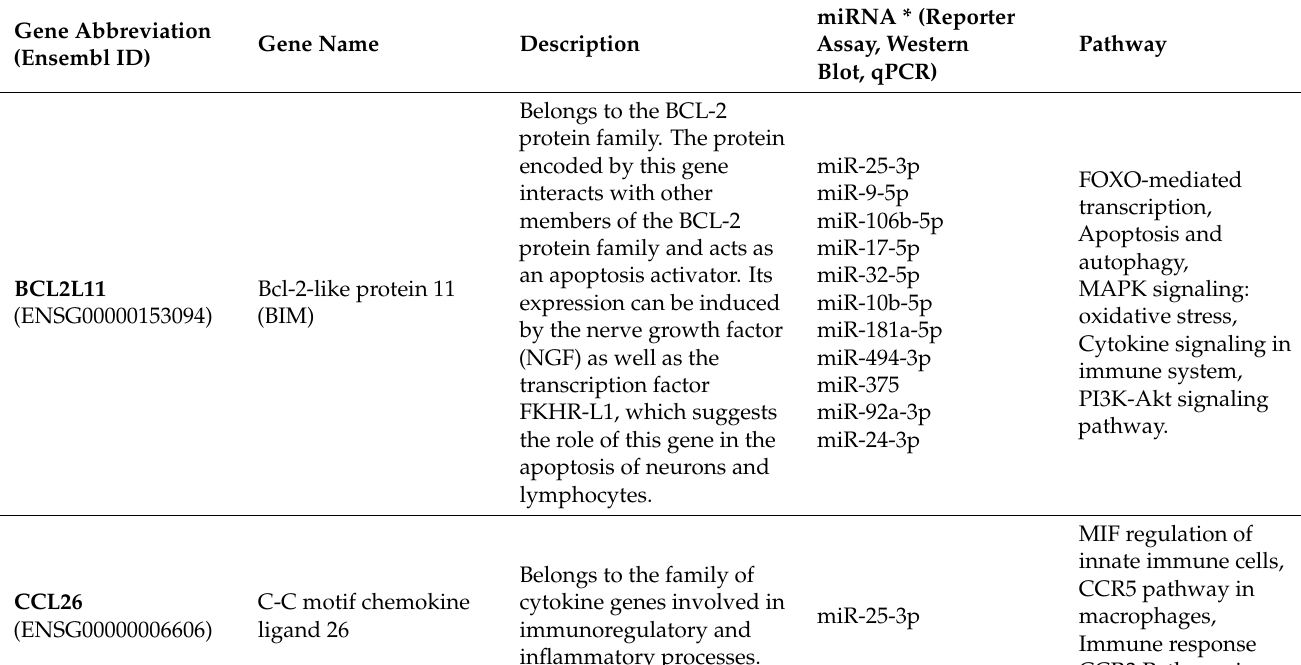
Table 6. MiRNA-regulated genes, and signaling pathways involved in immune response activation, oxidative stress, inflammatory responses, hypoxia, and